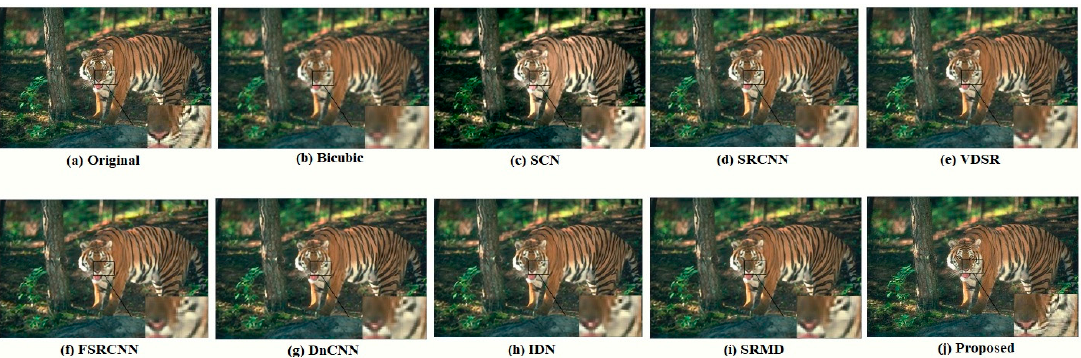
Figure 7. Visual comparison for the Barbara image at the scale-up factor of 2.